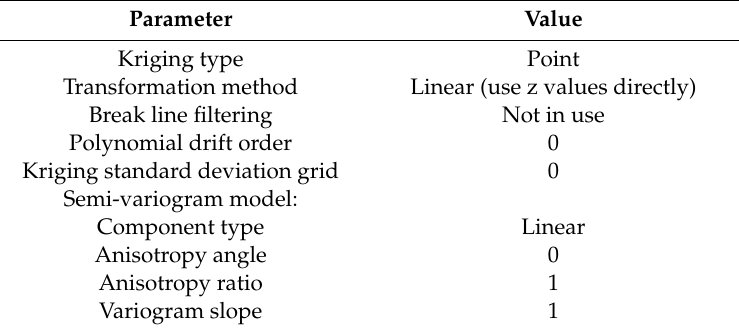
Table 1. Parameters for gridding utilized in the Kriging